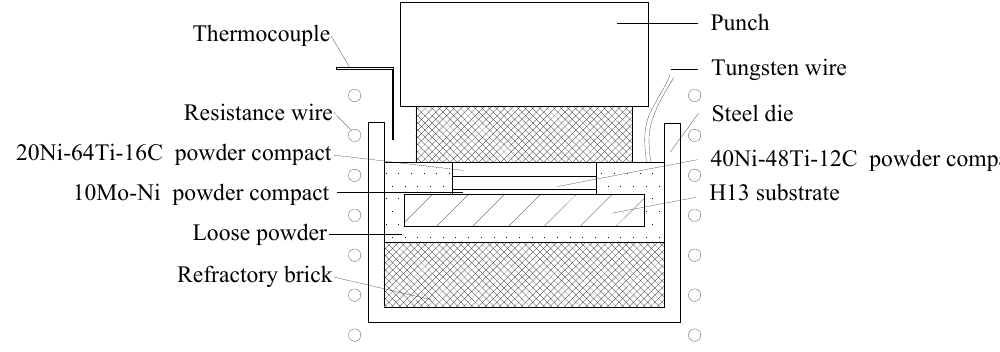
Figure 1. Schematic illustration of the fabrication of composite coating by SHS/PHIP.